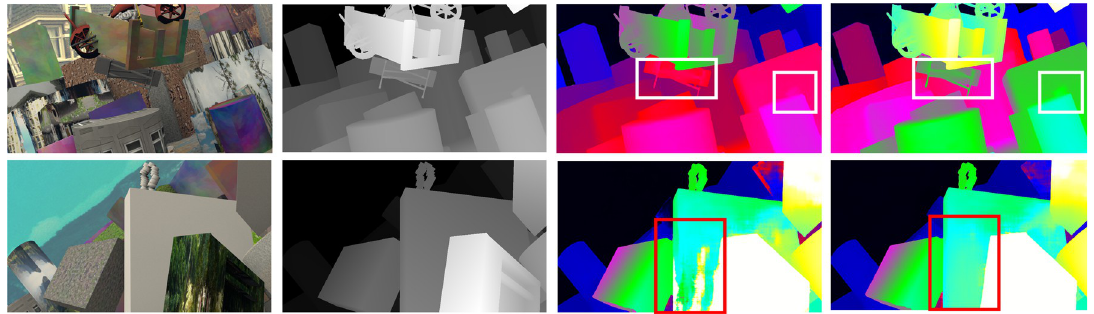
Fig 1. Comparisons with GWC-Net [13] on Scene flow dataset. First column: left input stereo image. Second column: the ground truth map corresponds to input image. Third column: predicted disparity map by GWC-Net. Last column: predicted disparity map by PA-Net. As shown in the white boxes in top row, PA-Net performance better in nearby objects under the guidance of PA module. In bottom row, our predicted disparity map performance better in recovering edge cues.